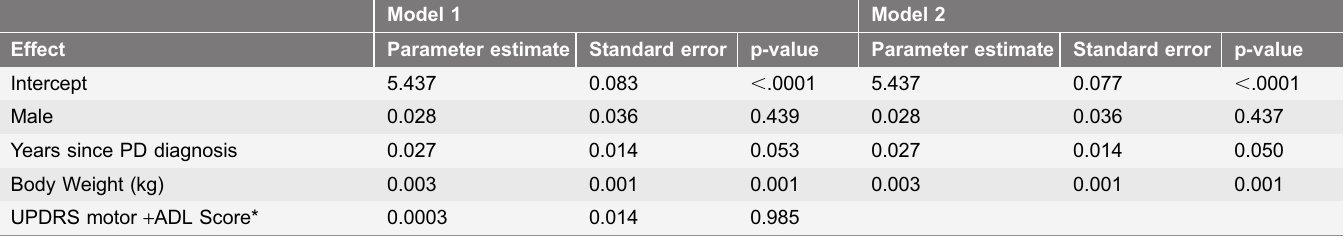
Table 3. Ln (Levodopa equivalent daily dose) regressed on sex, years since PD diagnosis, body weight, and UPDRS motor + ADL